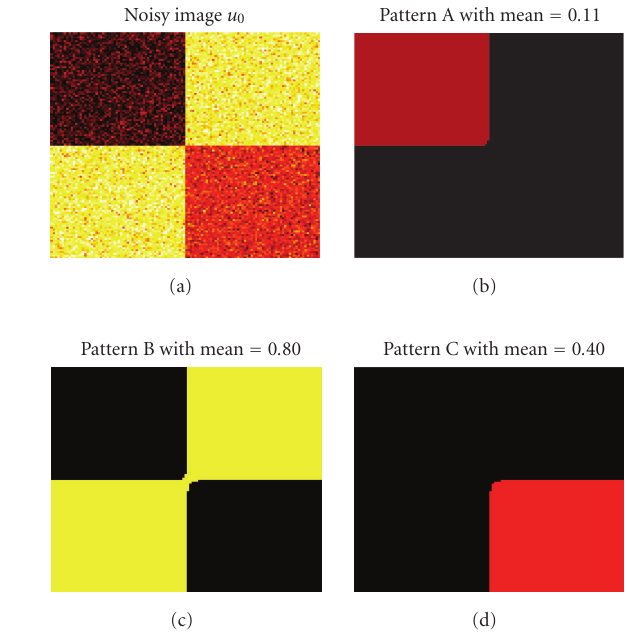
Figure 4: Synthetic image of a narrow bottleneck: hard segmenta- tion from the SMS model via “hardening” formulae (5) and (6). The thickening regularization at the bottleneck junction can be ex- plained similarly by the classical Mumford-Shah model for which minimum-surface or “soap-foam” behavior arises due to the sur- face tension energy. Also, see the recent work by Kohn and Slastikov [45] for the singularity analysis of a similar problem arising from